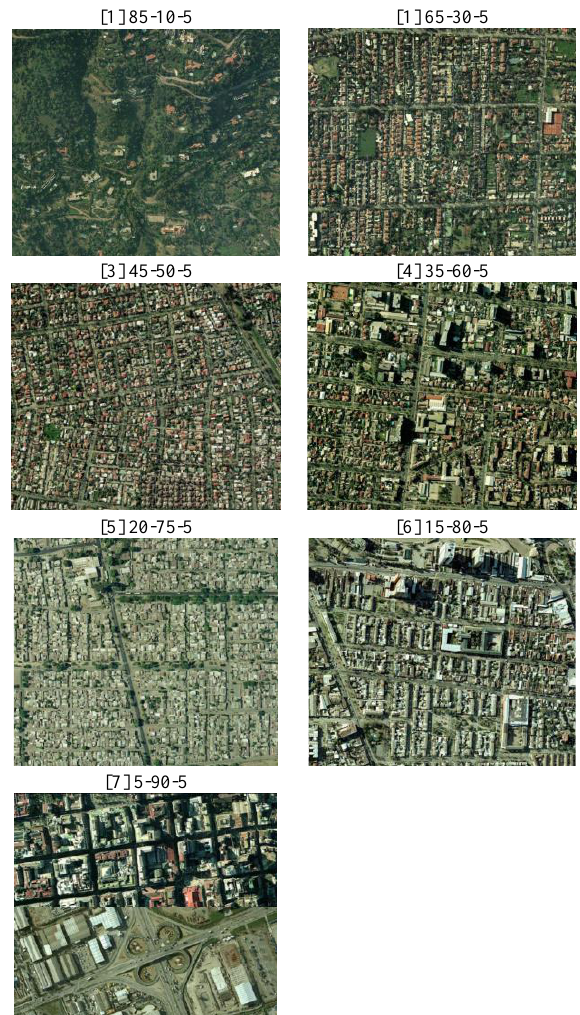
Figure 2. USTs for Santiago de Chile. [x]=indicates number of USTs and the three consecutive numbers indicate the percentage of the V-I-S components: V% - I % - S %. Images are from Google